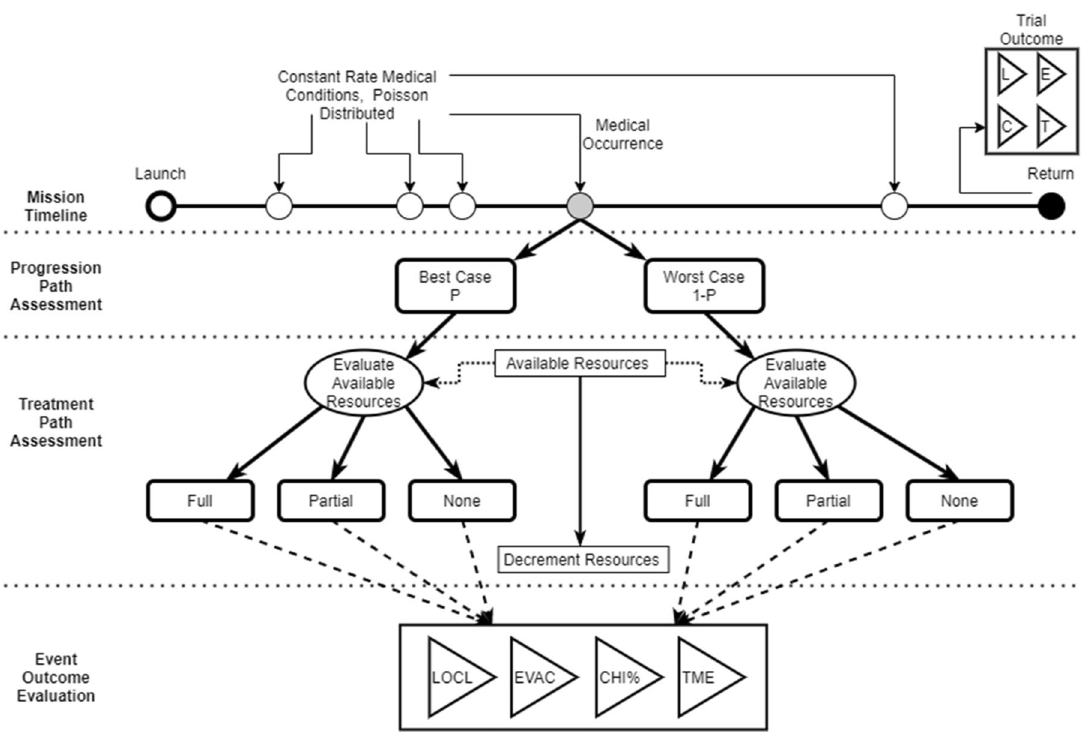
Fig. 1 The IMM 4.1 Monte-Carlo simulation incorporates a mission timeline, progression-path assessment, treatment-path assessment, and event-outcome evaluation. These are summed across all occurring conditions to provide a trial outcome and across all simulation runs to provide the simulation